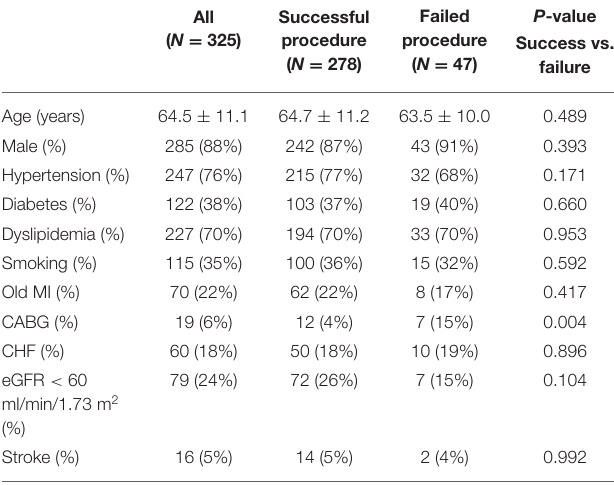
TABLE 1 | Comparisons of clinical features between successful and failed antegrade procedures. All ( N = 325)